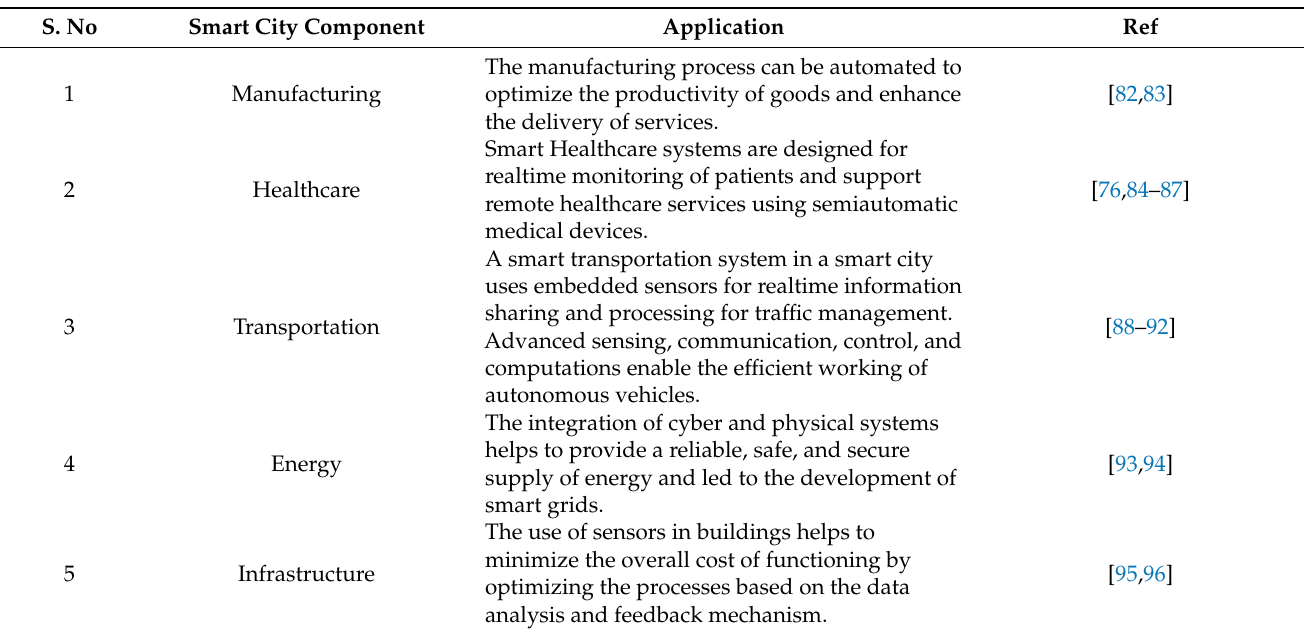
Figure 5. A typical medical CPS [45]. Table 1. Application areas of